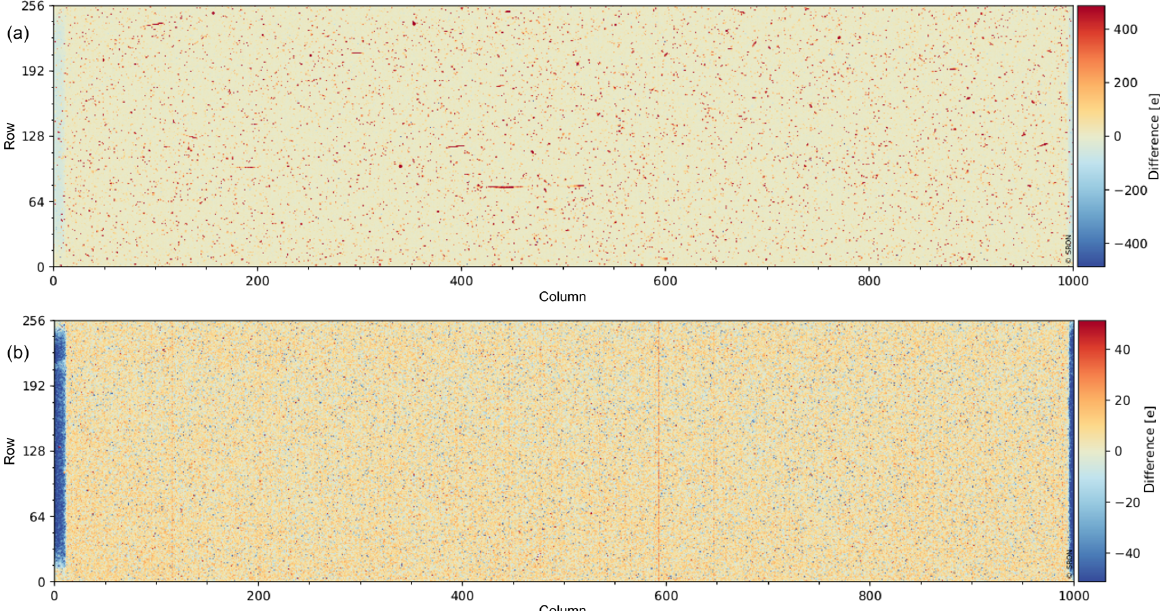
Figure 11. Comparison between the noise measured in-flight during orbit 2707 to 2722 and that measured on the ground. Panel (a) shows the difference between derivations using a root mean square while panel (b) shows that using a bi-weight spread. Note that the similarity of the difference between ground-based and in-flight noise measurements and the difference between the two methods, as shown in Fig. 10c.